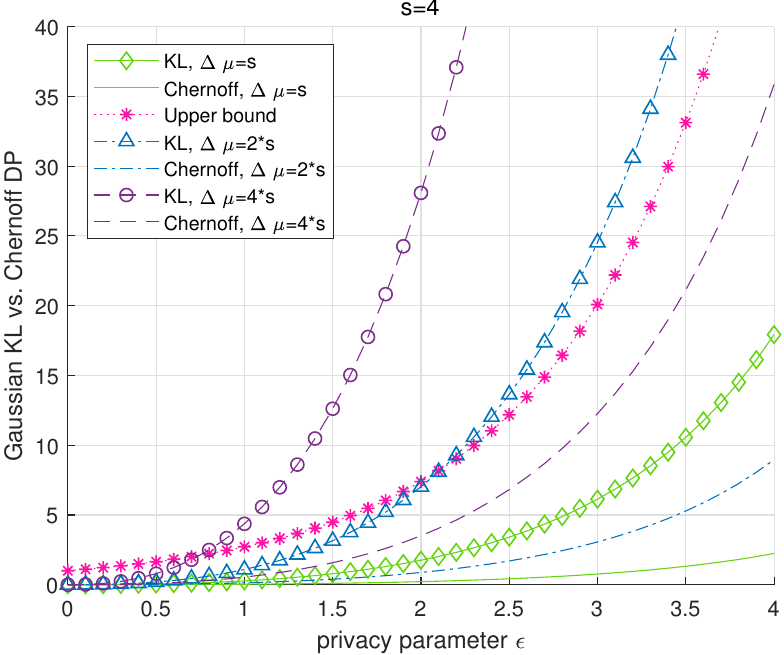
Figure 9. KL-DP vs. Chernoff DP for various levels of privacy budget with global sensitivity s =